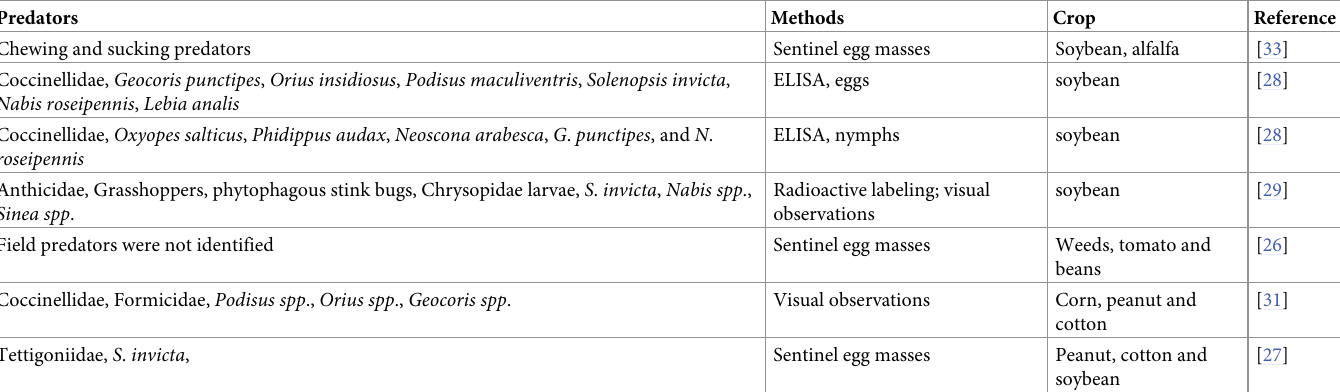
Table 1. Summary of previous studies on N . viridula , C . hilaris , and E . servus